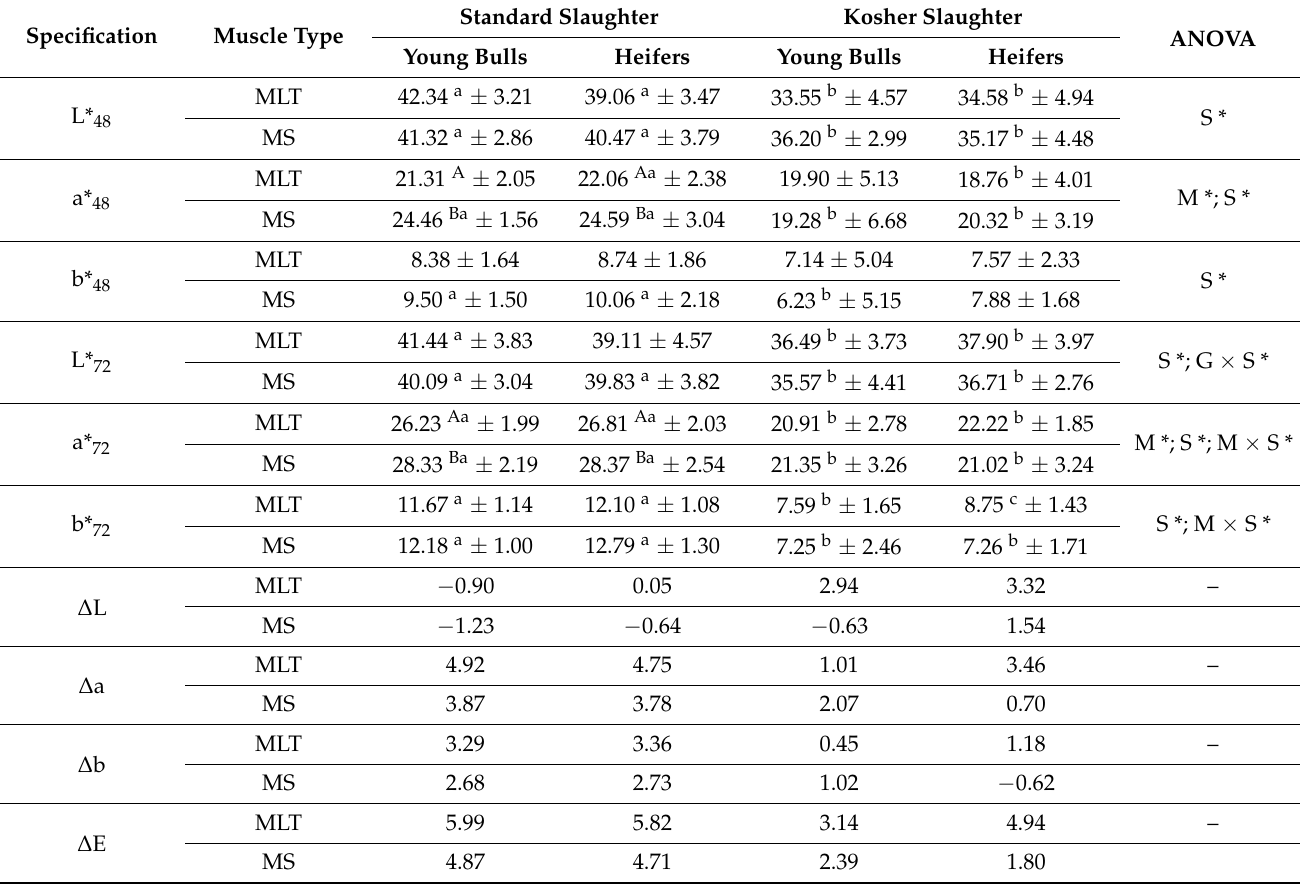
Table 1. Beef color parameters ( x ± SE) depending on slaughter type, muscle type, and gender